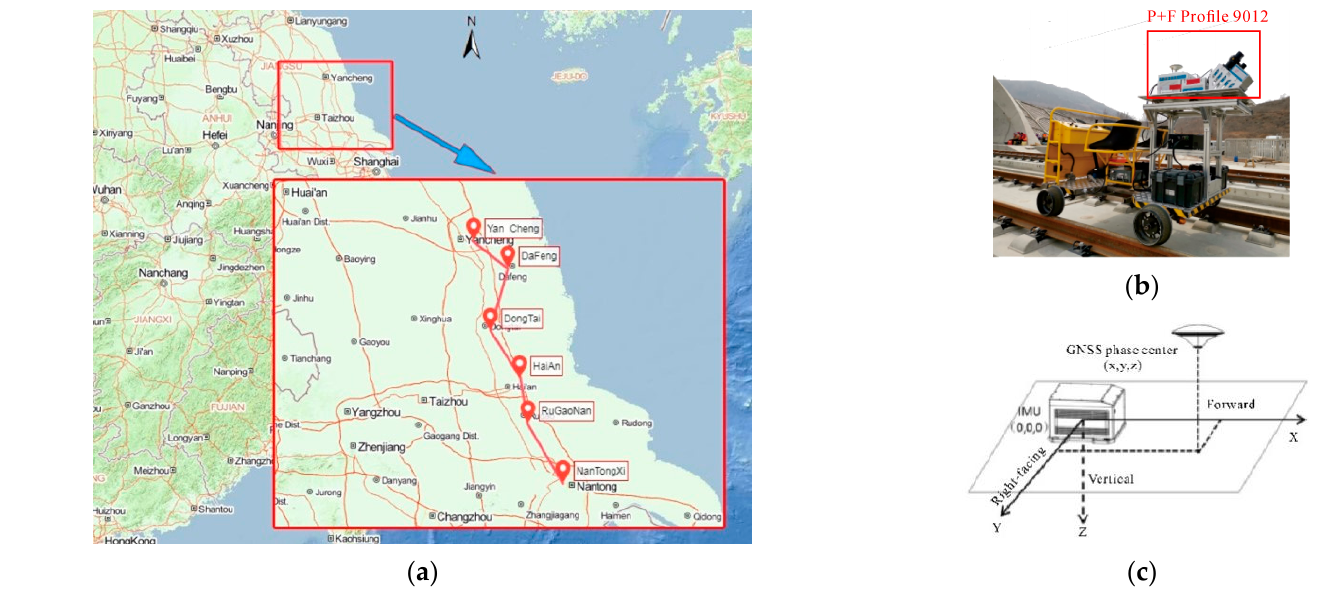
Figure 6. Experimental datasets. ( a ) Railway dataset from Yancheng to Nantong. ( b ) Z + F Profile 9012. ( c ) GNSS track acquisition device.